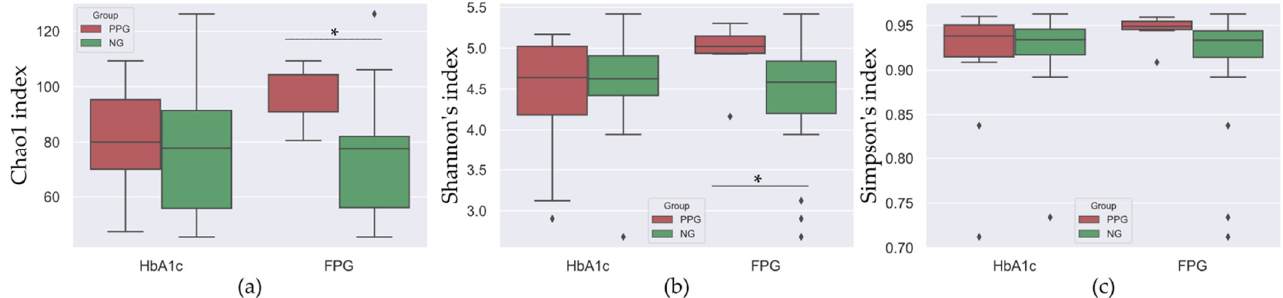
Figure 1. Chao1 ( a ), Shannon’s ( b ), and Simpson’s ( c ) diversity indices of saliva microbiomes in each sample group. In each panel, the PPG and NG groups divided by Hb1Ac and FPG levels are shown separately. The boxplots with red and green colors indicate 25% and 75% of the indices in PPG and NG groups, respectively. The diamond symbols are the outliers of the boxplot. The asterisks in ( a , b ) panels indicate the categories in which KS test reports have a significant difference ( p < 0.05).